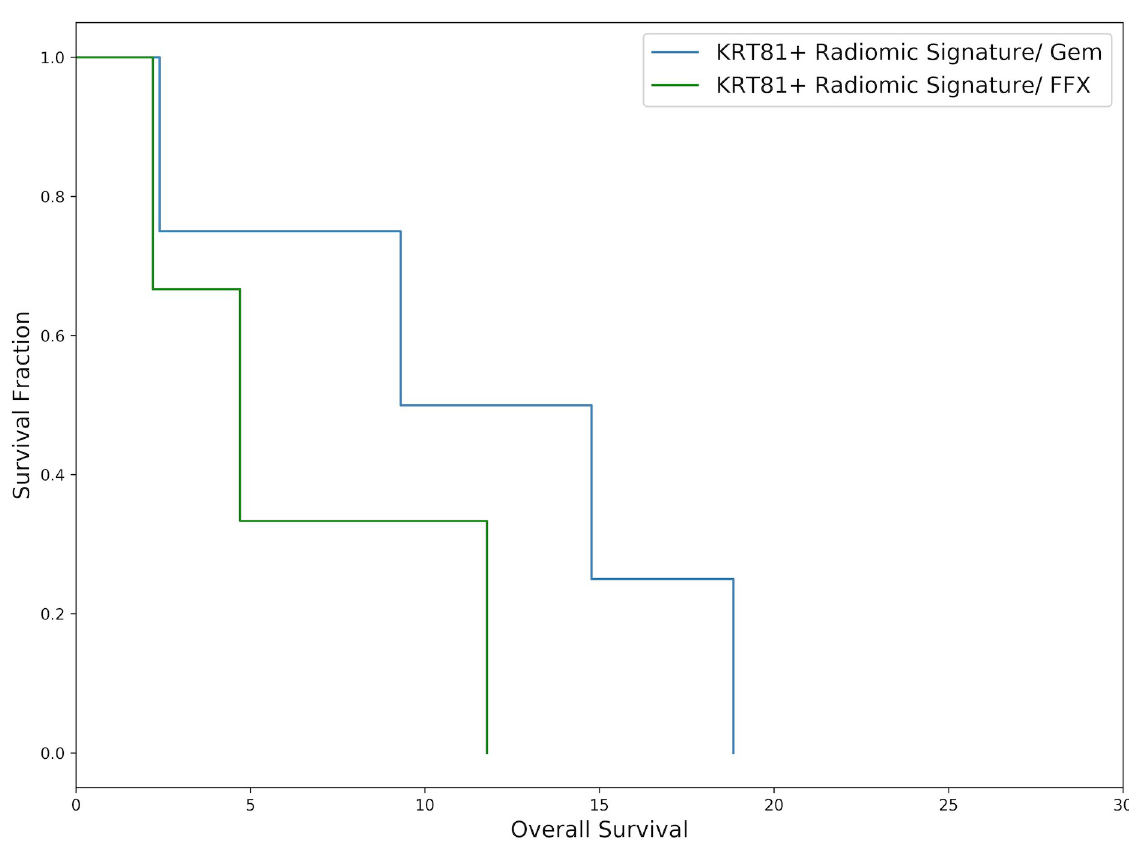
Fig 6. Exemplary Kaplan-Meier plot of patients with a predicted KRT81+/ high risk radiomic signature drawn from the 10 cross- validation folds and representing the median hazard ratio. Patients who received gemcitabine experienced improved survival, although no statistical significance is observed in this case (median survival 4.70 vs 9.30 months, p = 0.23, HR = 1.03, N =